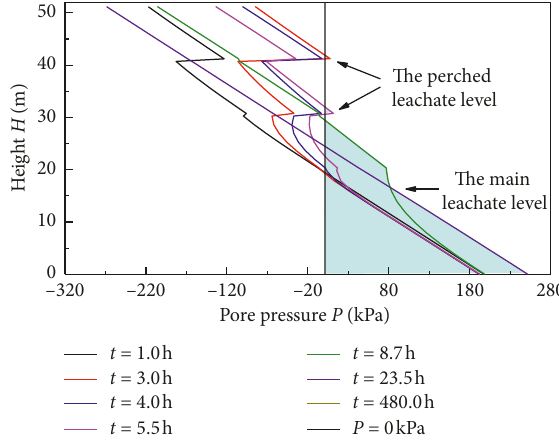
Figure 13: Vertical distribution curve of pore pressure at L 1 in Scheme 1.